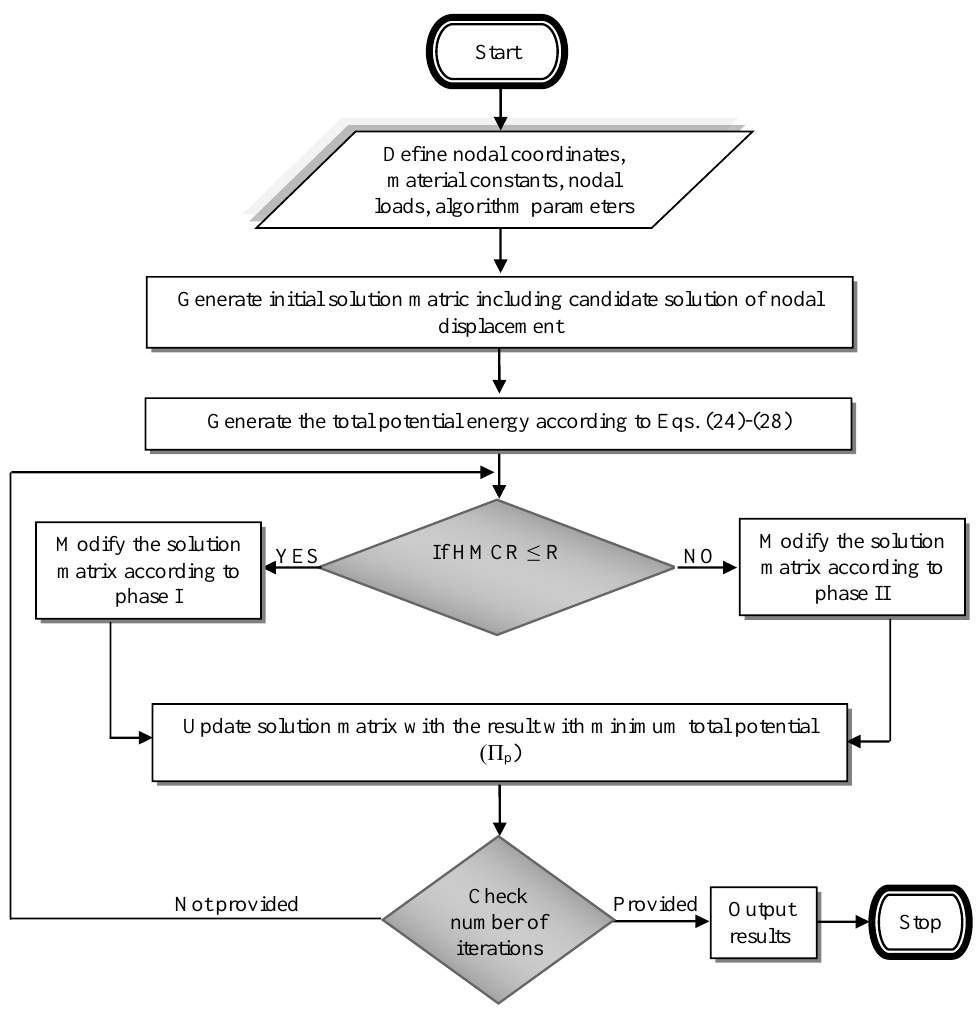
Figure 2. The flowchart of the total potential optimization using metaheuristic algorithms (TPO/MA).